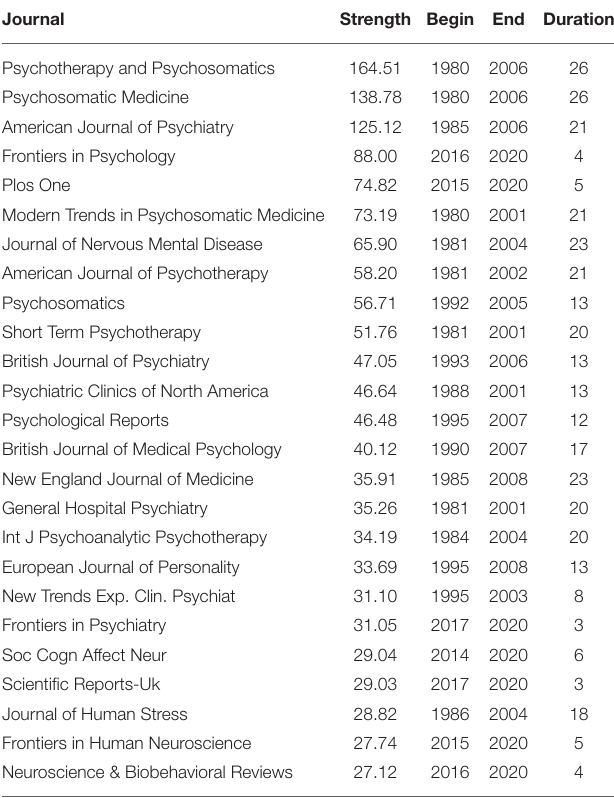
TABLE 3 | List of the top journals for burst strength, estimated via Journal Co-citation Analysis